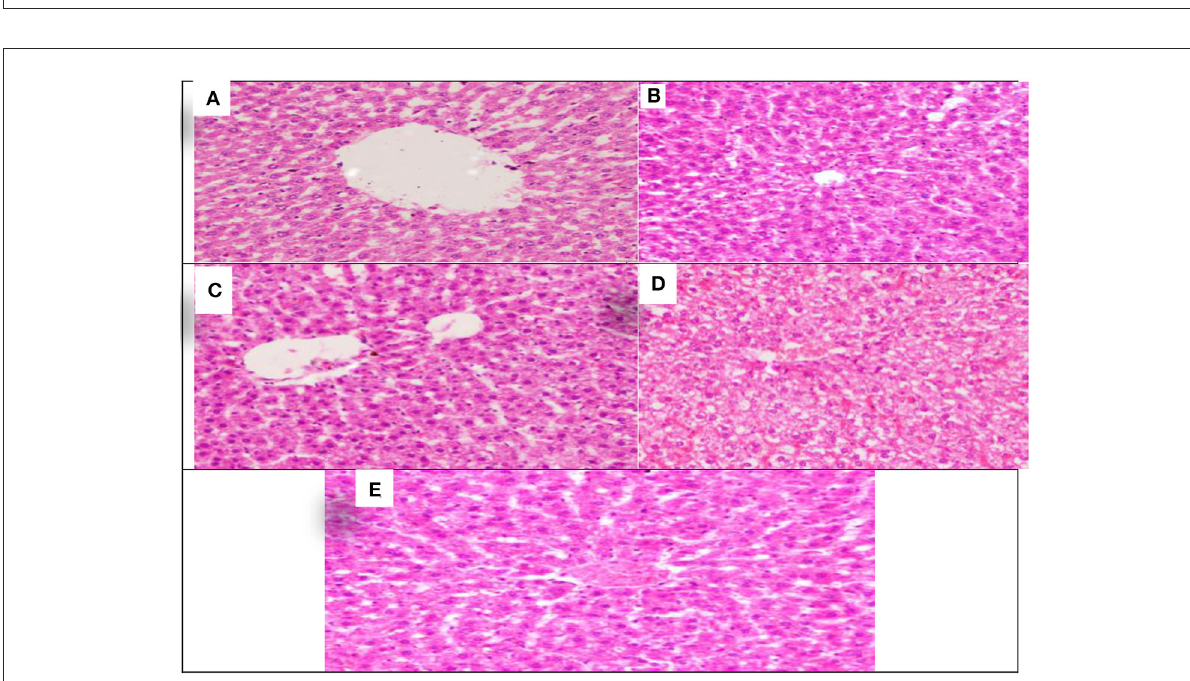
FIGURE2 Schematic diagram showing the effect of exposure to aluminum and medicinal plants and their mix on the histopathology of rats’ liver at 60 days after treatment. (A) Control group. (B) 1,600 ppm Aluminum. (C) 1,600 ppm Aluminum + Allium sativum 5%. (D) 1,600 ppm Aluminum + Nigella sativa 5%, and (E) 1,600 ppm Aluminum + Allium sativum 2.5% + Nigella sativa 2.5%.